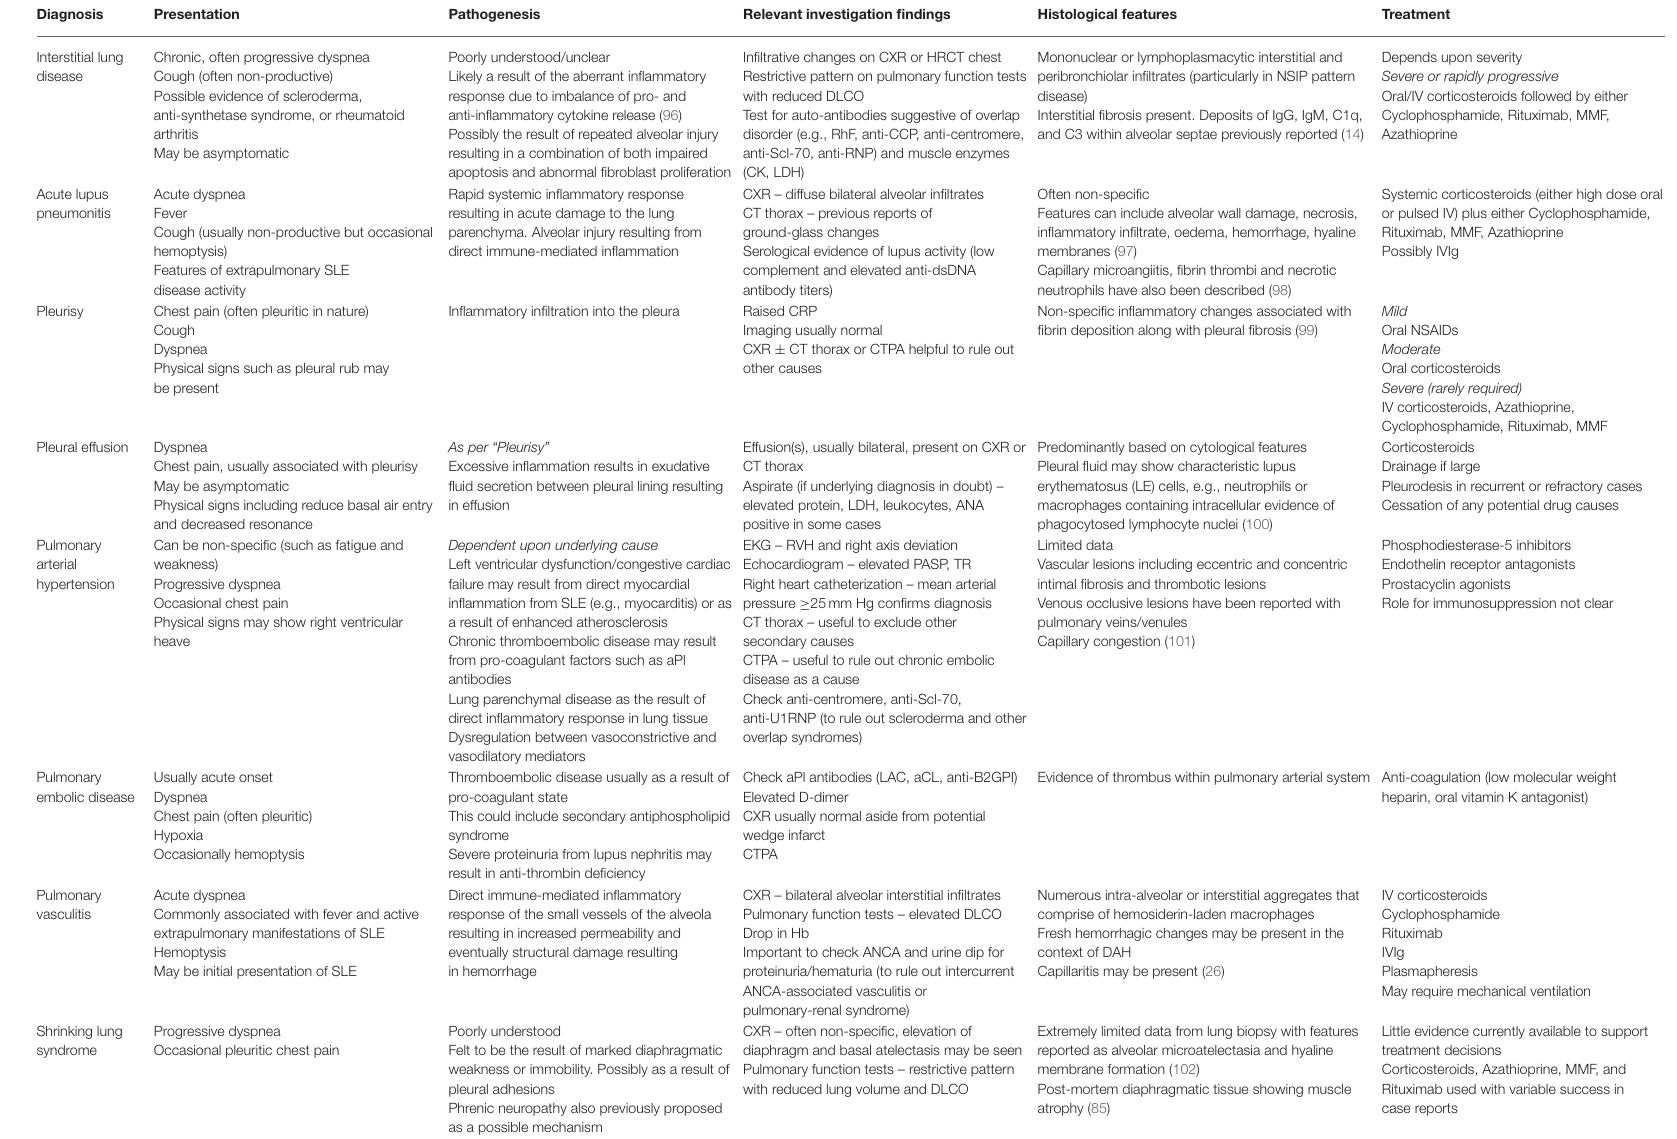
TABLE 1 | A summary of the way in which pulmonary manifestations of systemic lupus erythematosus (SLE) may present in clinical practice, the underlying pathogenesis and relevant treatment options.